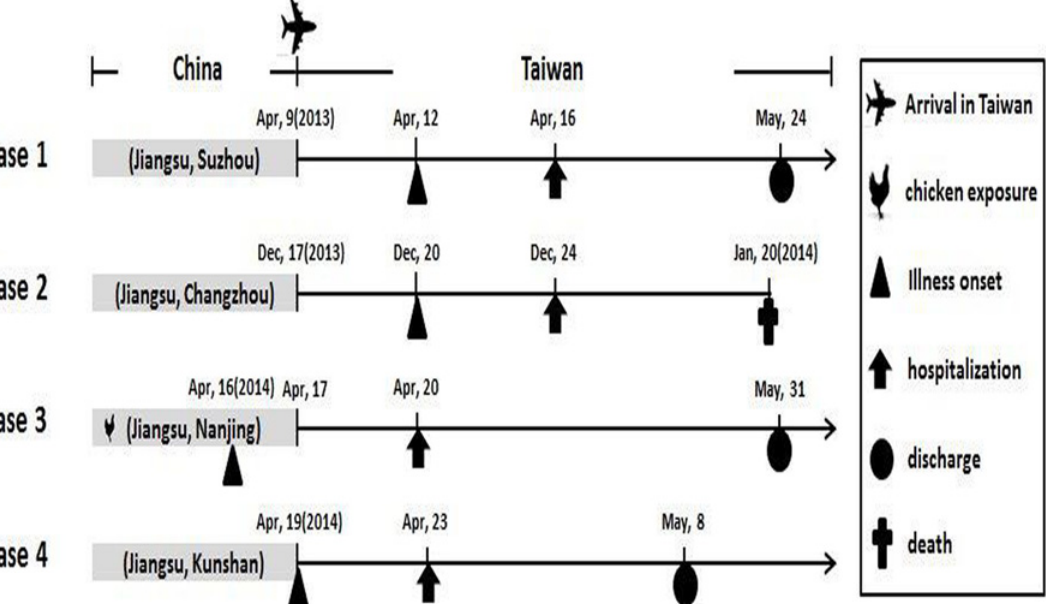
Fig 1. Information about the four confirmed H7N9 cases. The time points (dates) of previous chicken exposure, arrival in Taiwan, illness onset hospitalization and discharge for each case are indicated by symbols, as shown in the key. Provinces and cities where each imported case carried out daily activities before arrival in Taiwan are indicated in gray shadow boxes.